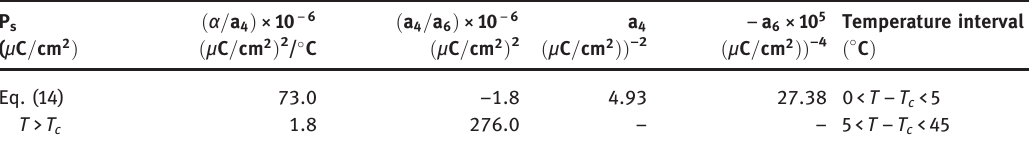
Table 3: Values of the coefficients for the spontaneous polarization P s at various temperatures according to eq. (14) in TMAHSO 4 within the temperature intervals